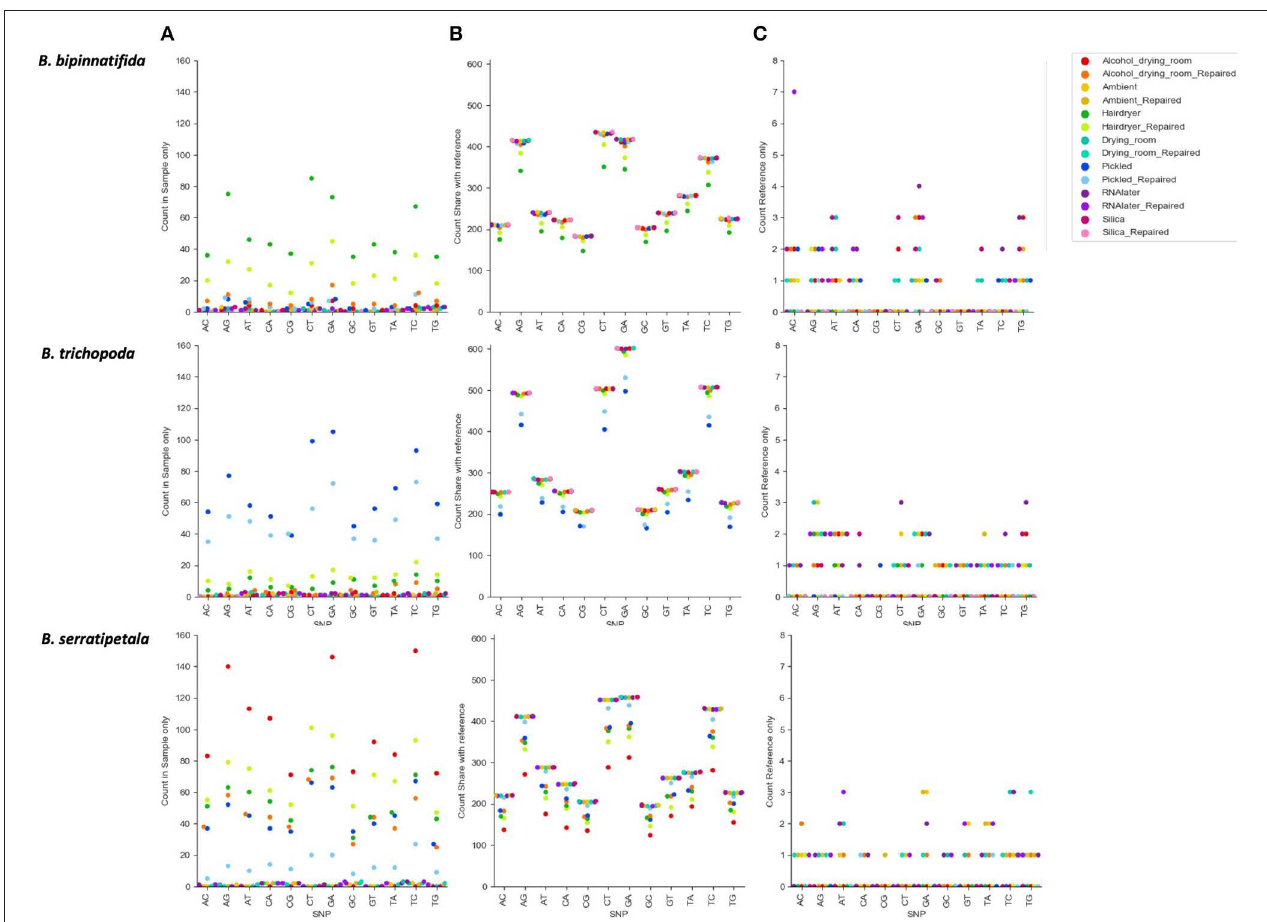
FIGURE 6 | Count of SNP types by species and by treatment. SNPs unique or shared between reference sample (silica dried repaired consensus) and different treatments (colored markers). (A) SNPs found in treatment sample only. These represent likely nucelotide changes due to treatment, or errors due to difficulty calling with low coverage. (B) SNPs shared between treatment sample and reference (true SNPS). (C) SNPs found in reference only (erroneously lost from treatment